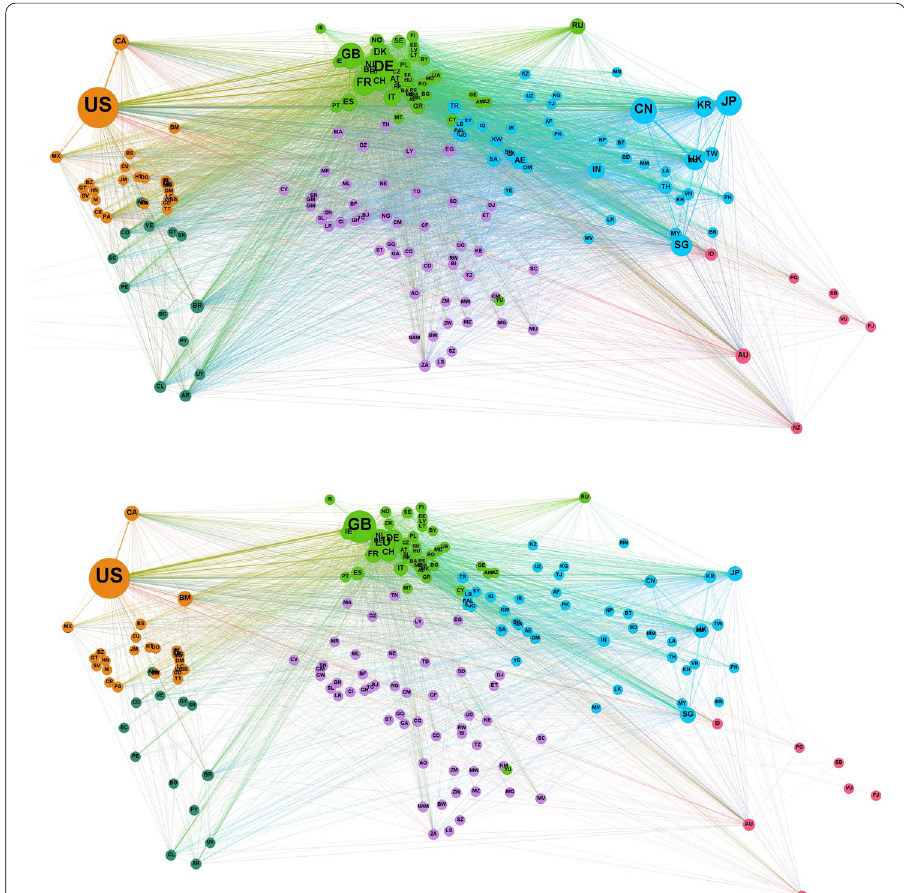
Fig. 3 The networks of Transportation (S205, top) and Financial services (S260, bottom) in year 2012. Node size is proportional to the total strength (i.e. import export flow), edges thickness to the weight. Only edges + with w ij ≥ 1 (million US dollars) are depicted